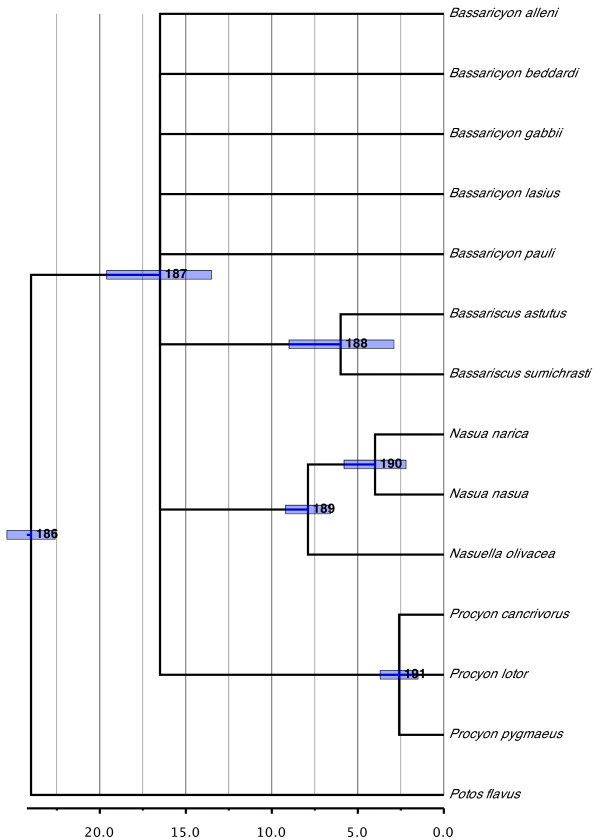
Phylogenetic relationships and divergence times estimates within Procyonidae. Nodes are individually numbered, with node bars indicating 95% confidence intervals on the divergence time estimates (in Ma before present).